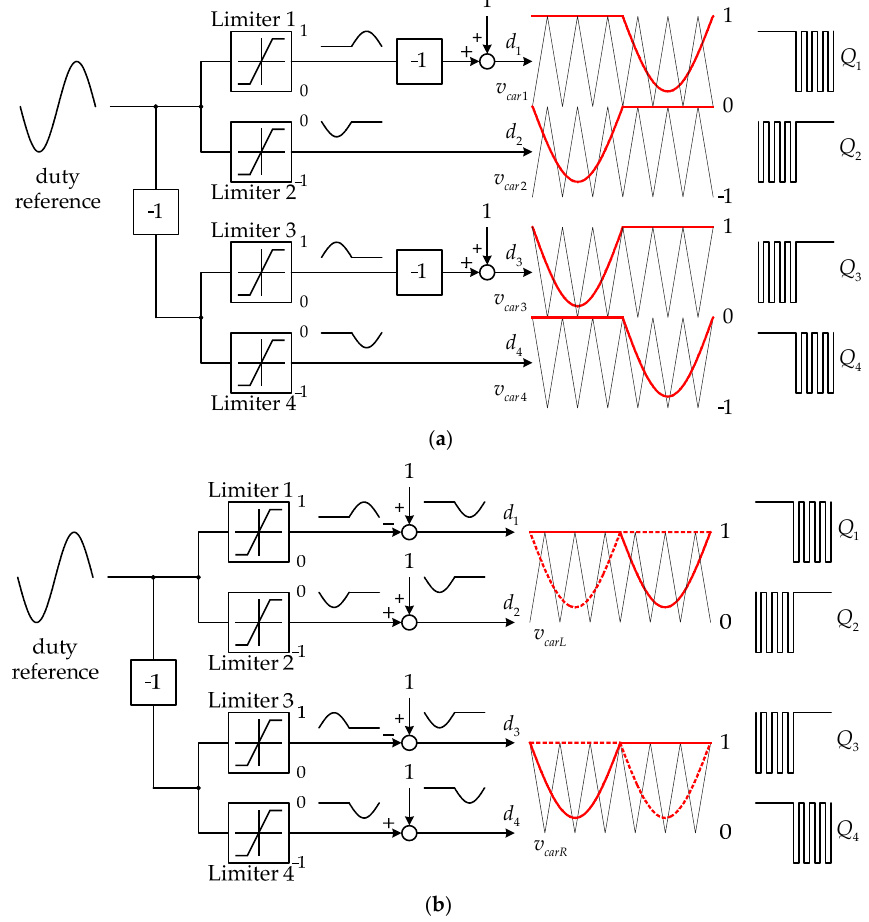
Figure 6. Modulation schemes for the PFC converter. ( a ) Original modulator; ( b ) Equivalent structure of the original modulator.